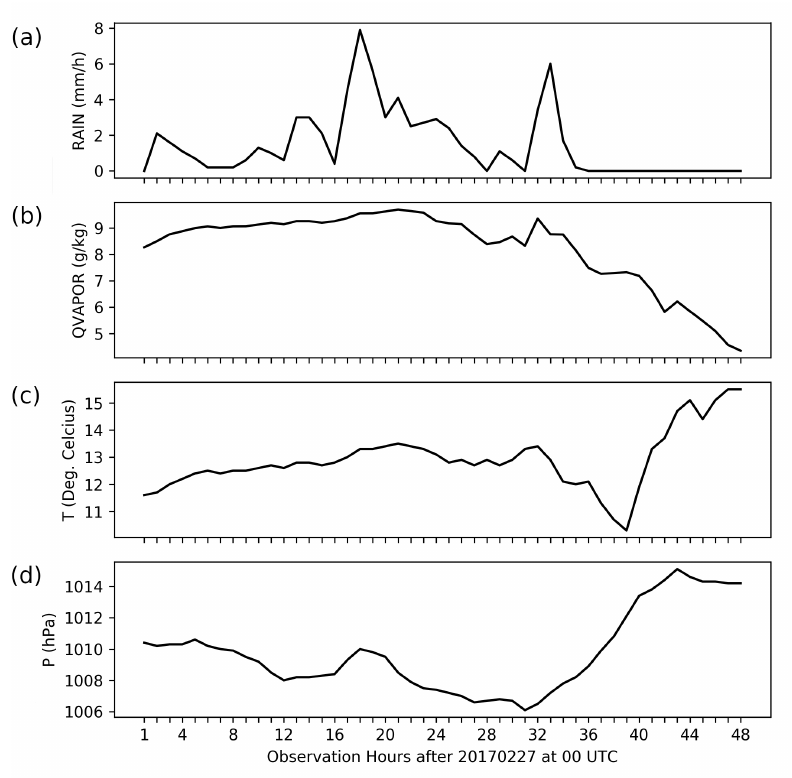
Figure 2. Observation data from the Lopez Zamora Station: ( a ) precipitation in mm/h, ( b ) water vapor mixing ratio in g/kg, ( c ) temperature in degree celsius, and ( d ) pressure in hPa. The horizontal axis represents the hours after 27 February 2017 at 00